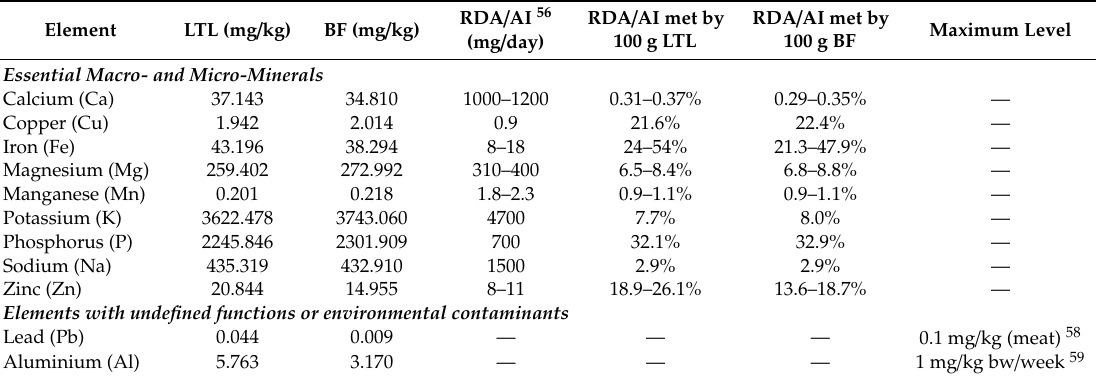
Table 3. Mean mineral levels (mg / kg meat) found in fallow deer ( n = 12) longissimus thoracis et lumborum and biceps femoris muscles compared with relevant dietary recommendations or maximum intake levels for adults. The superscript numbers indicated for the RDA / AI and maximum levels refer to references in the reference